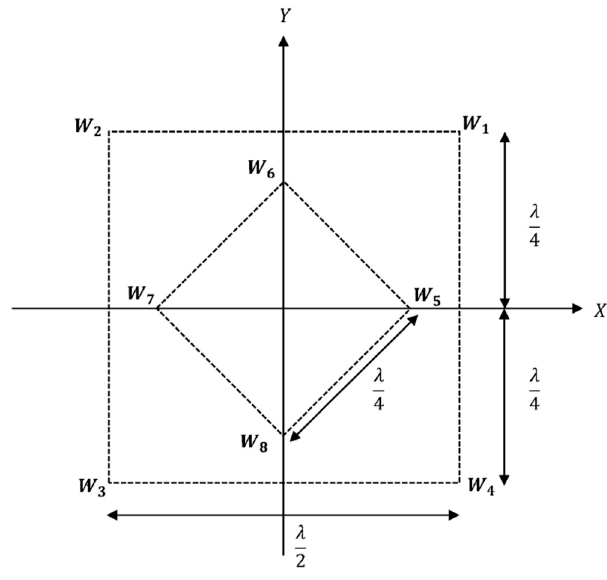
Figure 5. Schematic Diagram of the Proposed Two-Square Configuration 2.